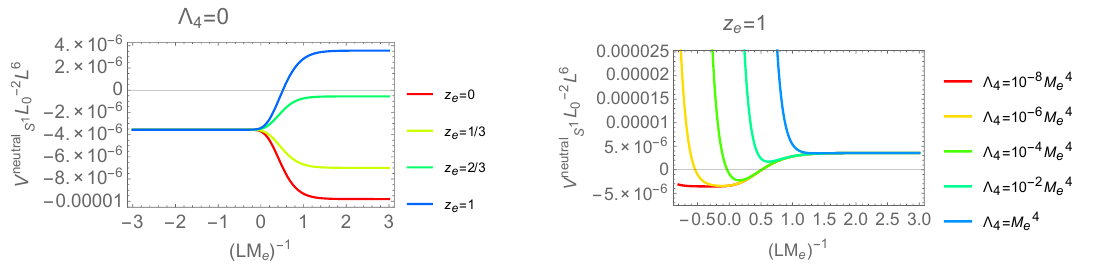
Figure 3 . The potential of compacti(cid:12)ed U(1) gauge theory with neutral matter. In the left (cid:12)gure, (cid:3) 4 is set to be zero. In the right (cid:12)gure, periodic boundary condition, z e = 1, is